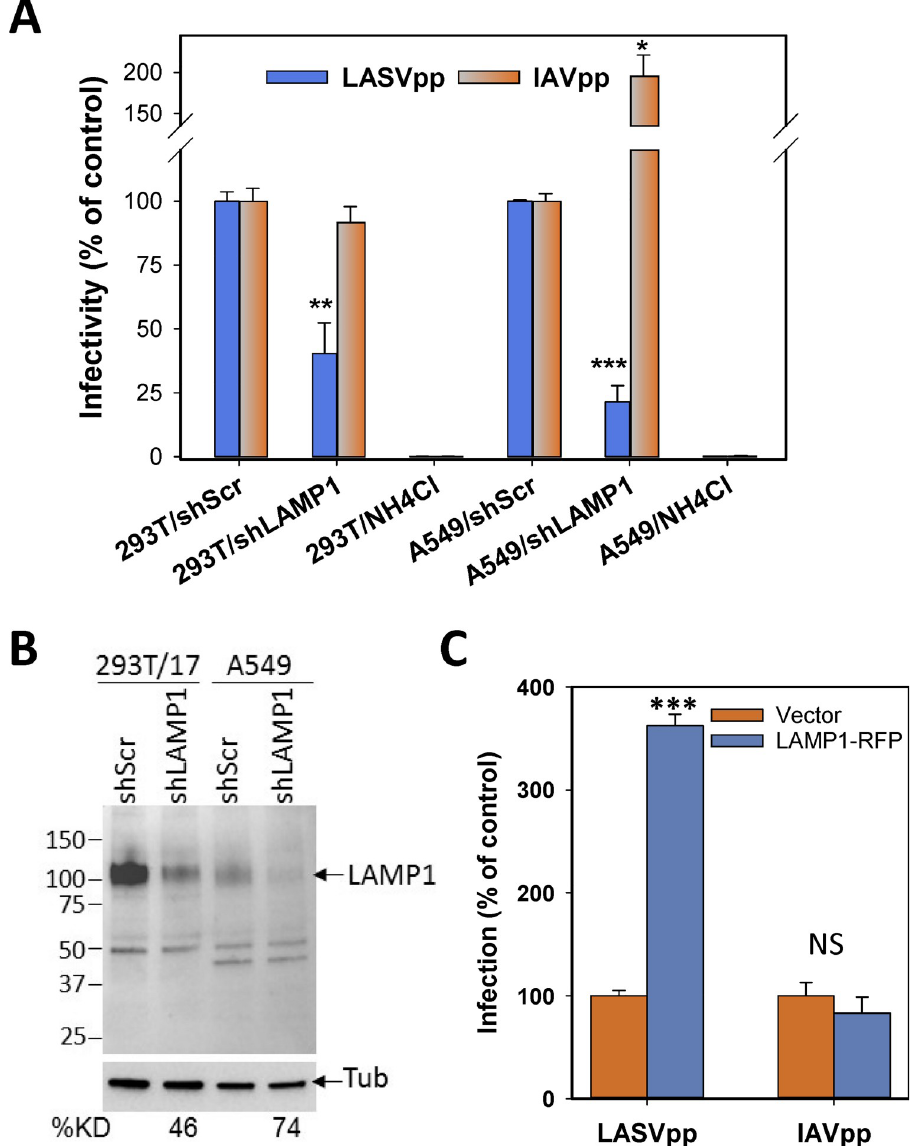
Fig 1. pH- and LAMP1-dependence of LASV pseudovirus infection. (A) Human HEK2393T or A549 cells transduced with control (shScr) or LAMP1-specific shRNA (shLAMP1) were infected with luciferase-encoding HIV-1 particles pseudotyped with LASV GPC (LASVpp) or Influenza A HA/NA glycoproteins (IAVpp). Control infections were done in the presence of 30 mM NH 4 Cl to block virus entry from endosomes. The resulting luciferase signal was measured at 48 hpi and plotted as mean and SEM from three independent experiments performed in duplicate. (B) Western blot analysis of LAMP1 expression and the efficiency of shRNA knockdown in HEK293T and A549 cells. Densitometry analysis of LAMP1 expression levels relative to control cells is shown under the bottom panel. Anti- tubulin served as the loading control. (C) LASVpp infection of avian QT6 cells transfected with an empty vector or human LAMP1-mRFP encoding plasmid. Data are mean and SD for two independent experiments performed in triplicate. � , p < 0.05, �� , p < 0.01, ��� , p < 0.001, NS, not significant.